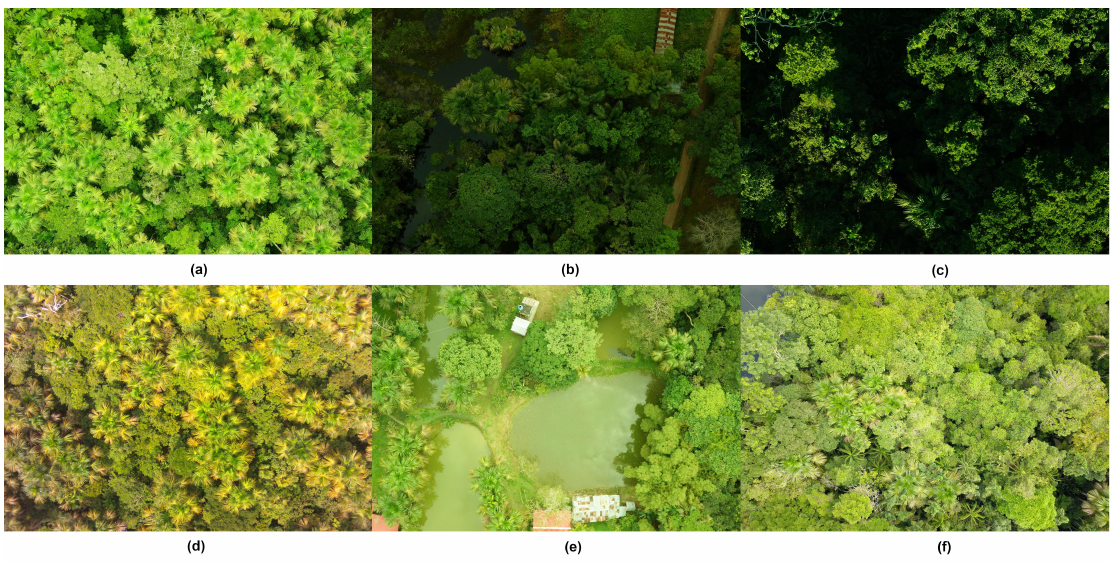
Figure 3. Aerial images acquired by different UAVs. ( a ) Cloud-free region captured with a Sony Nex-7. ( b ) Shadowed region captured with a Sony Nex-7. ( c ) Aerial image acquired in the afternoon with a Sony Nex-7. ( d ) Aerial image captured by the Skyranger UAV with vignetting. ( e ) and ( f ) Aerial images captured by the Mavic Pro